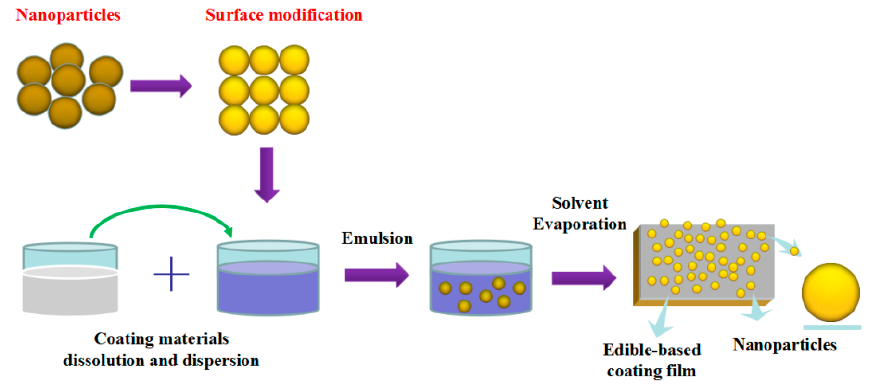
Figure 3. The general technology to prepare the ECF with NPs.